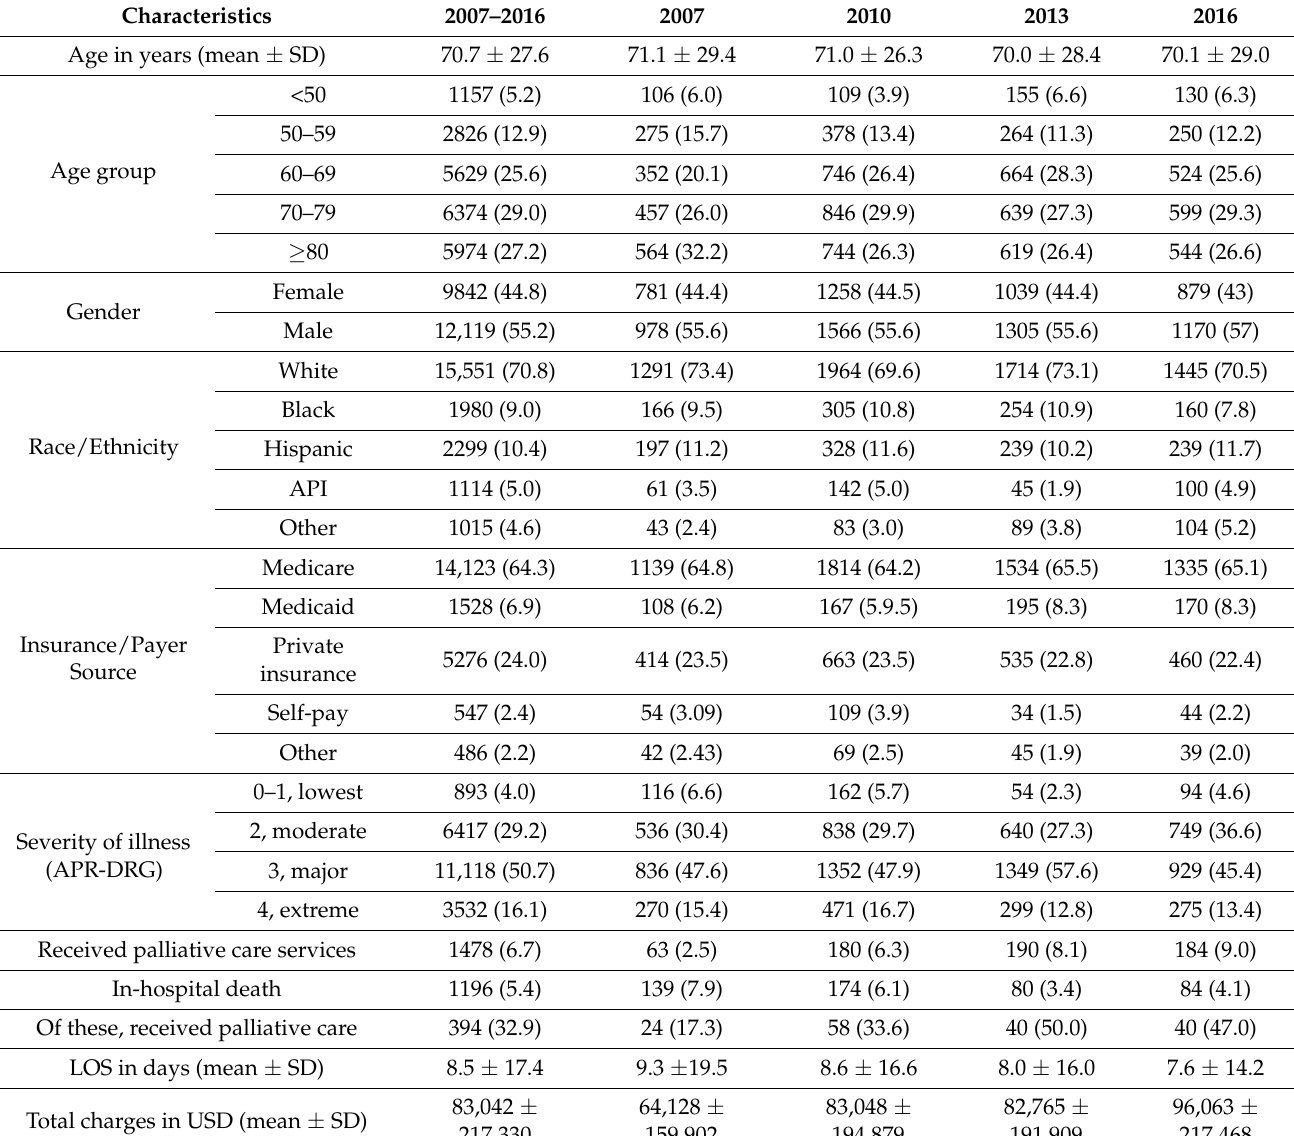
Table 1. Demographic, clinical, and hospital characteristics of 22,028 ECC hospitalizations (weighted national estimate) in US hospitals (2007–2016; NIS Data) *